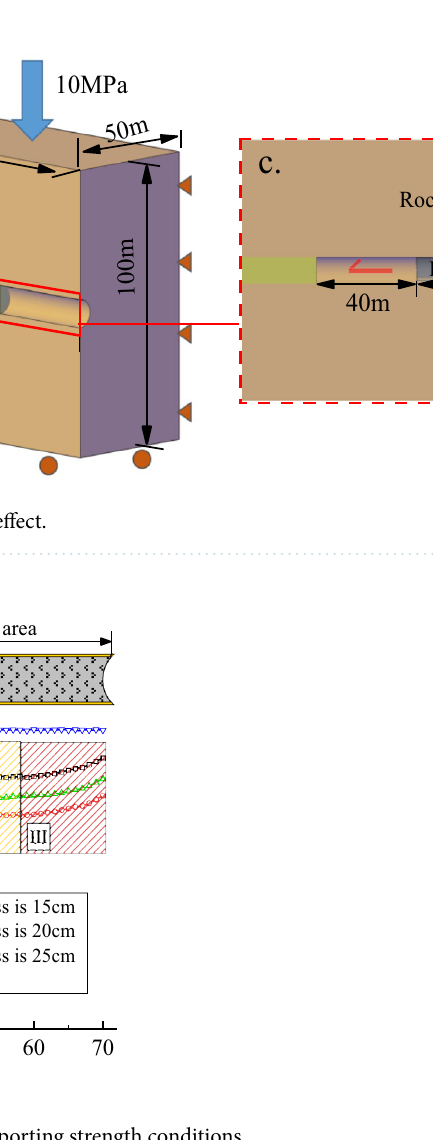
Figure 2. Support constraint effect for different supporting strength